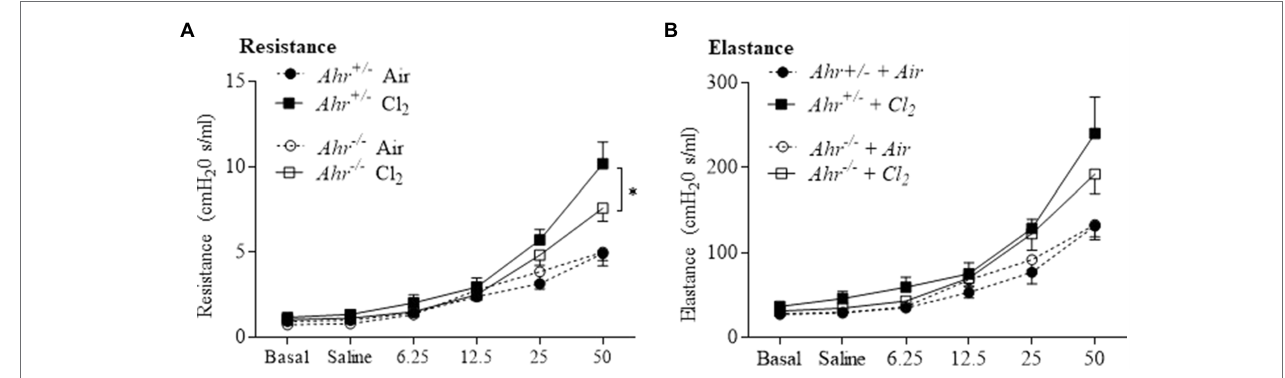
FIGURE 7 | Aryl hydrocarbon receptor increases airway hyperresponsiveness after Cl 2 exposure. Lung mechanics parameters included assessment of resistance (A) and elastance (B) by flexiVent in response to methacholine in Ahr+/ − and Ahr − / − at 24 h after exposure to air or Cl 2 . Cl 2 increased resistance compared with the control. Respiratory resistance was significantly lower in Ahr − / − mice compared with Ahr+/ − mice at the highest dose of methacholine (* p = 0.0358). Results are expressed as the mean ±